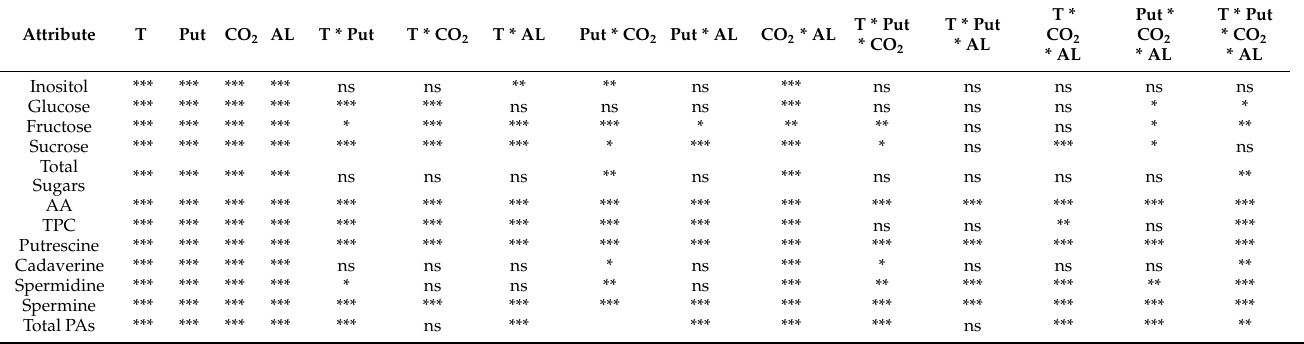
Table 1. An ANOVA analysis of sugars, AA, TPC, and polyamines affected by putrescine treatment, the level of CO 2 , short-heat stress, and the age of